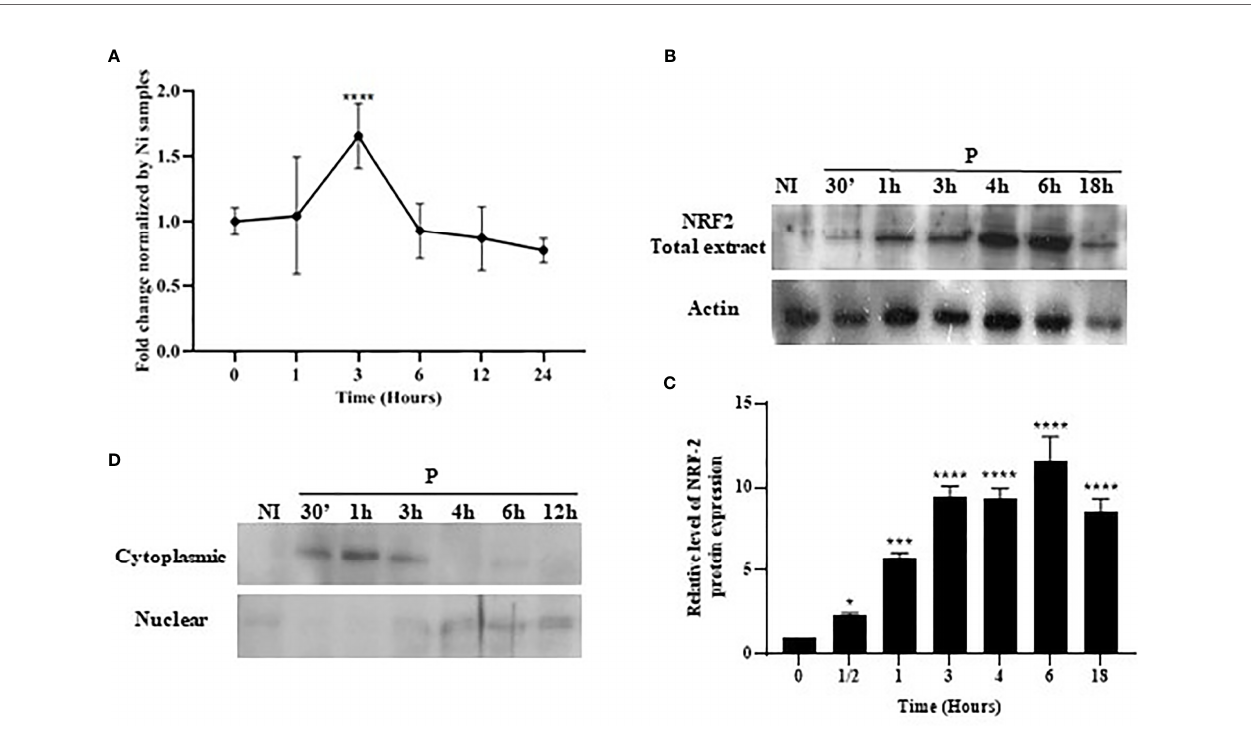
FIGURE 2 | Stimulation and nuclear accumulation of Nrf2 in response to Leishmania major infection. Balb/c bone marrow-derived macrophages (BMdMs) and/or Raw264.7 cells were infected for the indicated time period with L. major promastigotes. (A) The extracted mRNAs were used to perform RT-PCR. (B) Total Nrf2 expression was evaluated at the protein level by immunoblotting. (C) Densitometric quanti fi cation of the NRF2 protein levels using ImageJ. All data are expressed as the mean ± SD from two independent experiments. * p < 0.05, *** p < 0.001, **** p < 0.0001 vs . non-stimulated BMdMs (two-way ANOVA). (D) Total protein extracts were fractionated into cytoplasmic and nuclear extracts and immunoblots performed with an anti-Nrf2 antibody. ERK1/2 and PARP were used to con fi rm the ef fi cacy of cytosol and nuclear